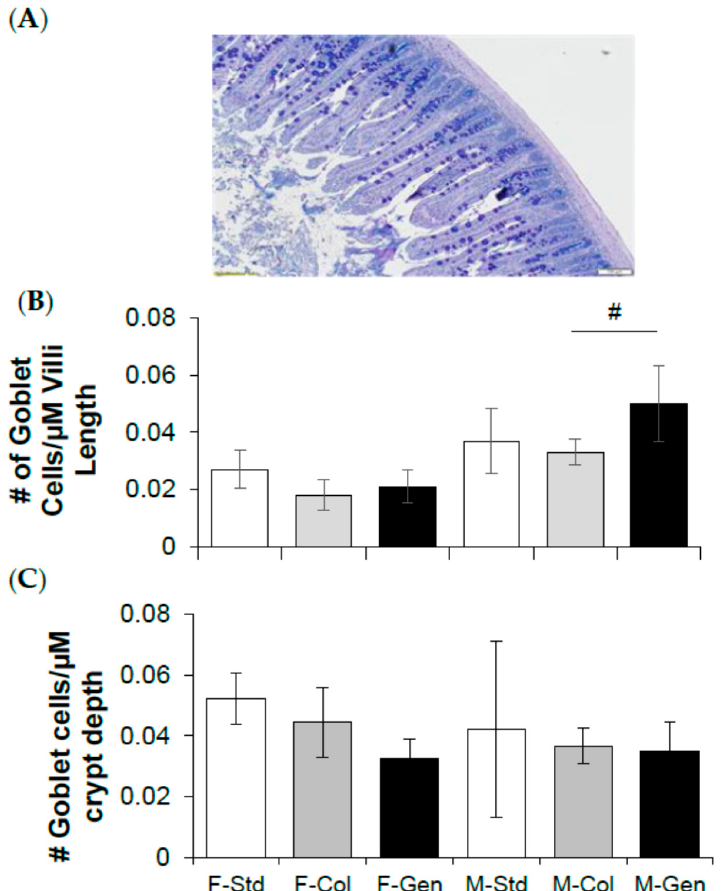
Figure 3. Effect of dietary genistein on jejunum morphology of Δ F508-CF mice. ( A ) Representative alcian blue stained section from jejunum. ( B ) Average number of goblet cells per micrometer of villi length ( n = 6/group). ( C ) Average number of goblet cells per micrometer of crypt depth ( n = 6/group). Note: Std = standard diet, Col = colyte treated, and Gen = genistein diet. Data are mean ± SD. # indicates significant genistein-mediated difference compared to colyte-treated, p < 0.05.